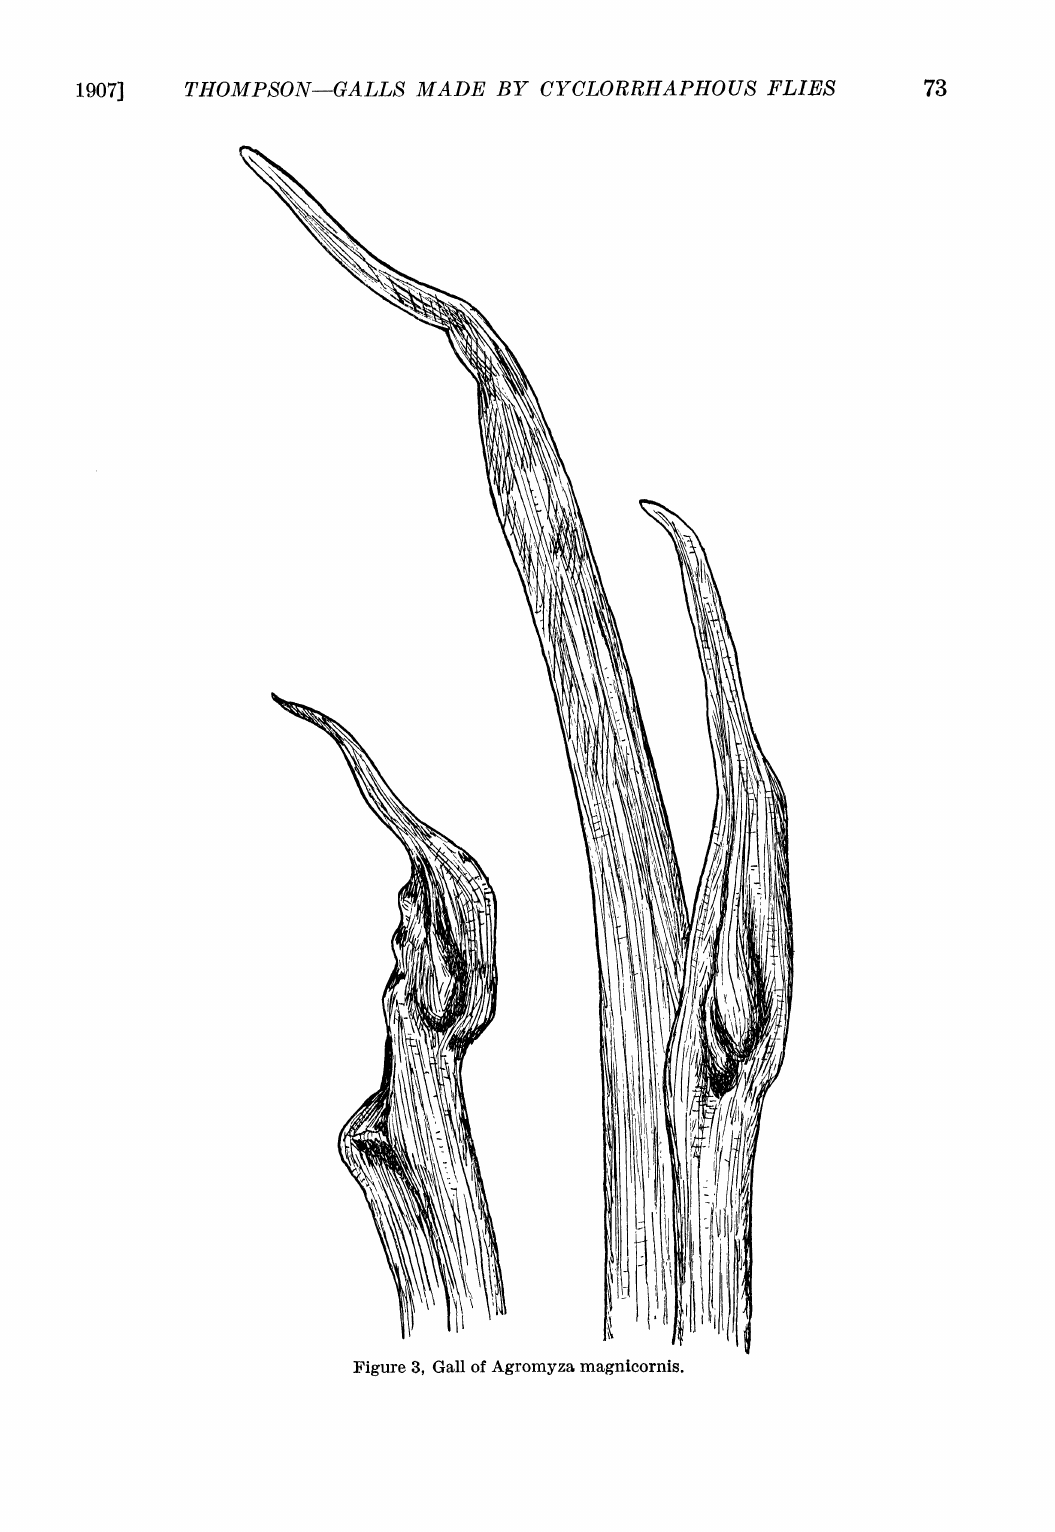
Figure 3, Gull of Agromyza